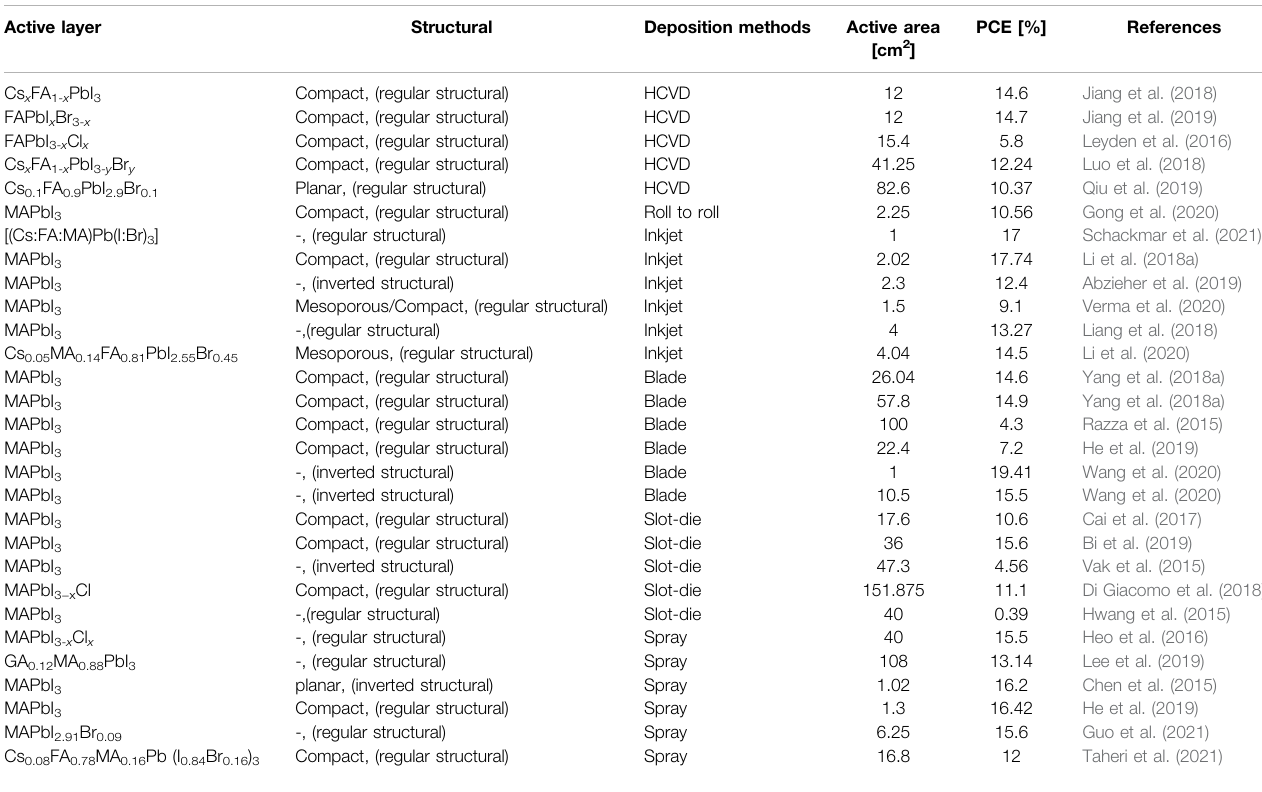
TABLE 1 | The perovskite solar cells through the various fabrication process. Active